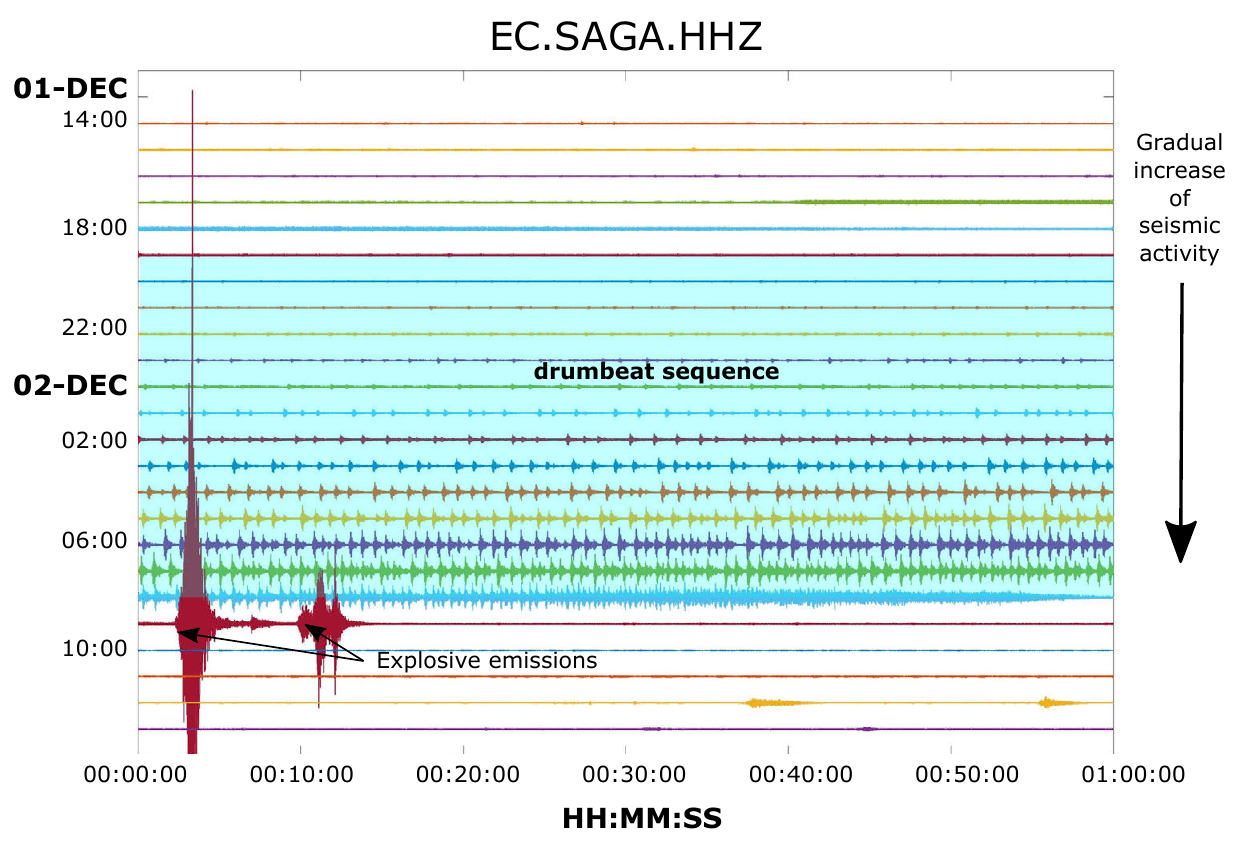
Figure 9: Helicorder of SAGA seismic station showing the drumbeat sequence, the merging of events into continuous tremor and the termination of these events in two energetic, explosive emissions. The traces are filtered between 0.25 and 16 Hz. 08:30 UTC on 2 December before decreasing. During